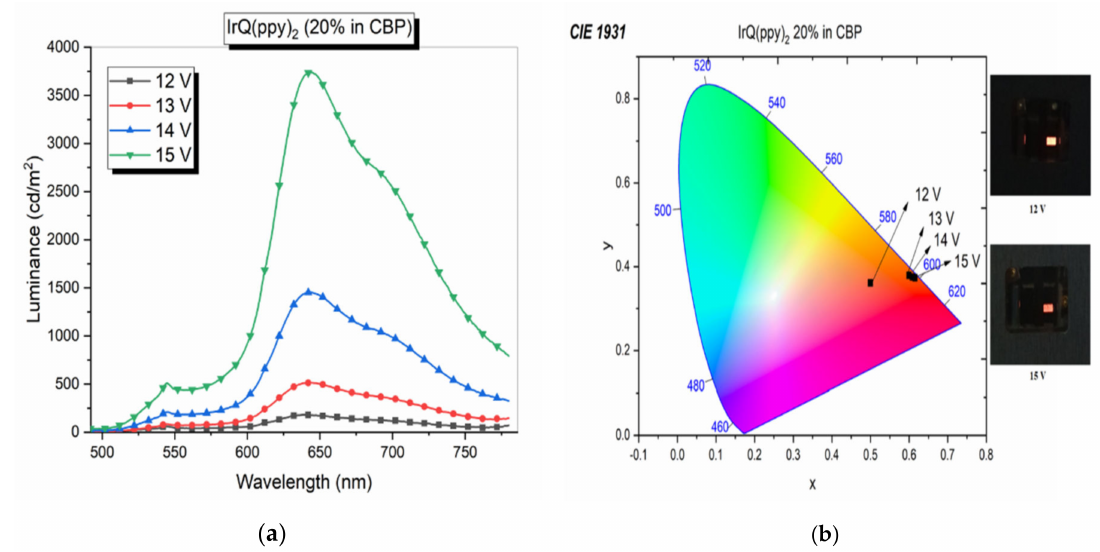
Figure 6. Luminance versus bias voltage ( a ); CIE and image colors versus bias of IrQ(ppy) 2 in CBP( b ). Because the IrQ(ppy) 2 in PVK does not change their luminance with the applied voltage, even at higher voltages, up to 16 V, we resume the comparisons only to the devices of IrQ(ppy) 2 in CBP (10% and 20%). In Figure 7a,b is given the current density and luminance curve as a function of applied voltage for these two devices.